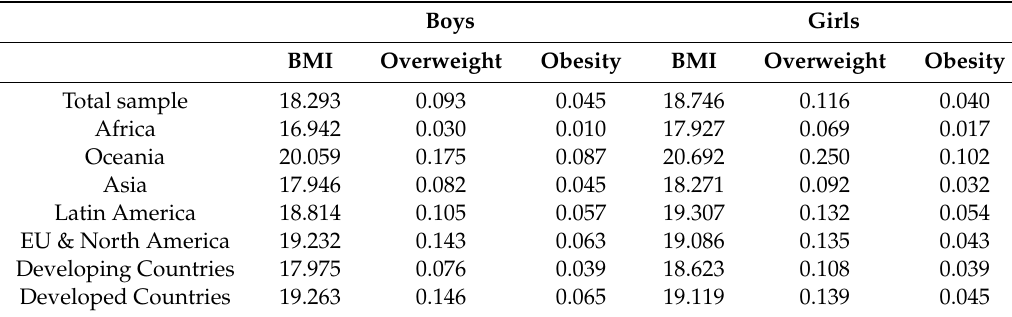
Table 1. Overall sample means by gender and regions: 1975–2016. Boys